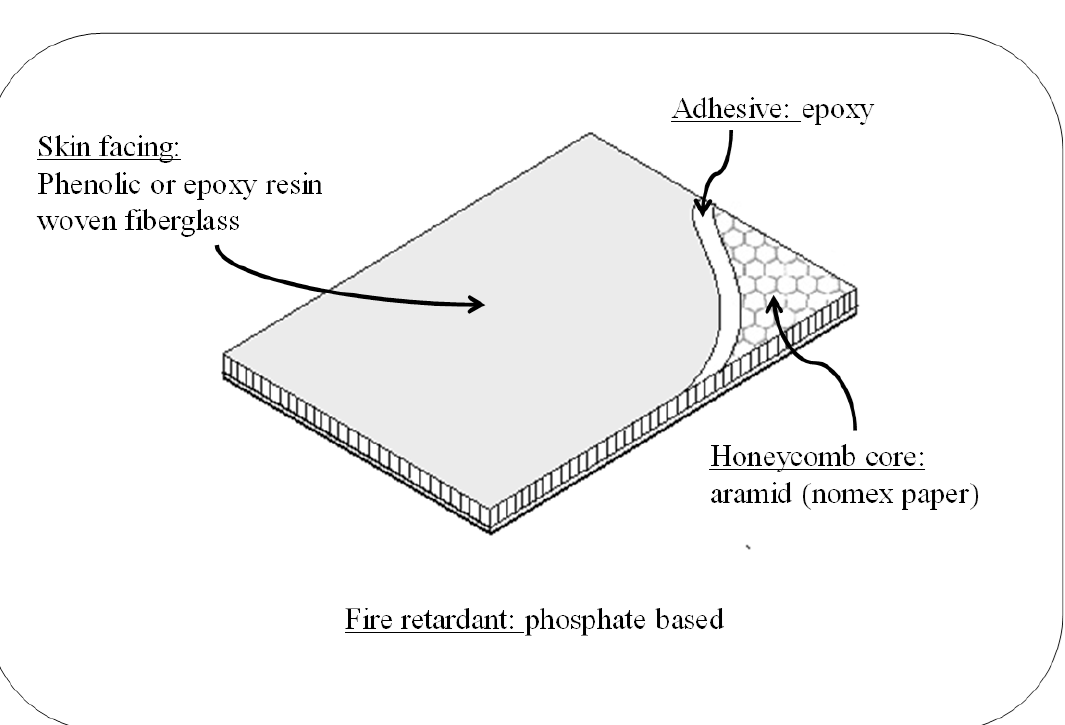
Figure 3: Honeycomb sandwich panels used in the case study.